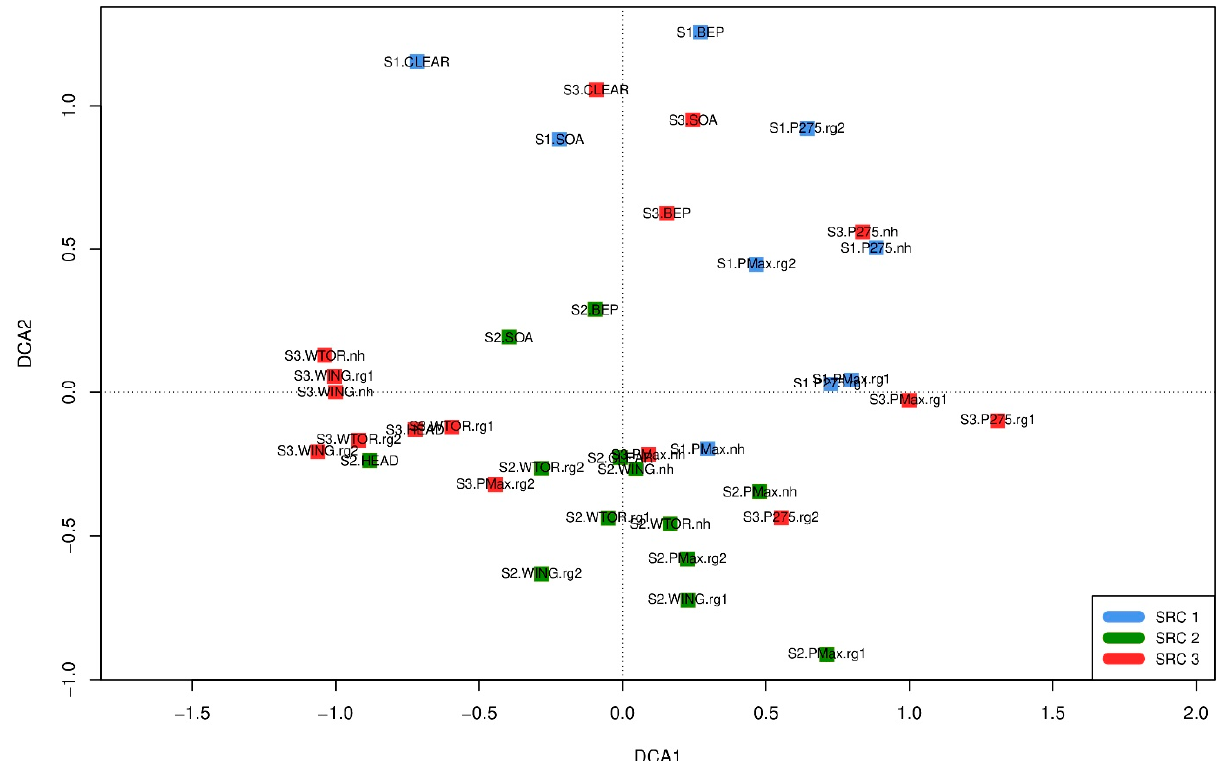
Figure 8. DCA ordination of the individual stands of the different SRC stand types. See Table 2 for abbreviations of SRC stand types. Eigenvalue axis 1: 0.3243, axis 2: 0.2540, length of axis 1: 2.3706, axis 2: 2.1698.